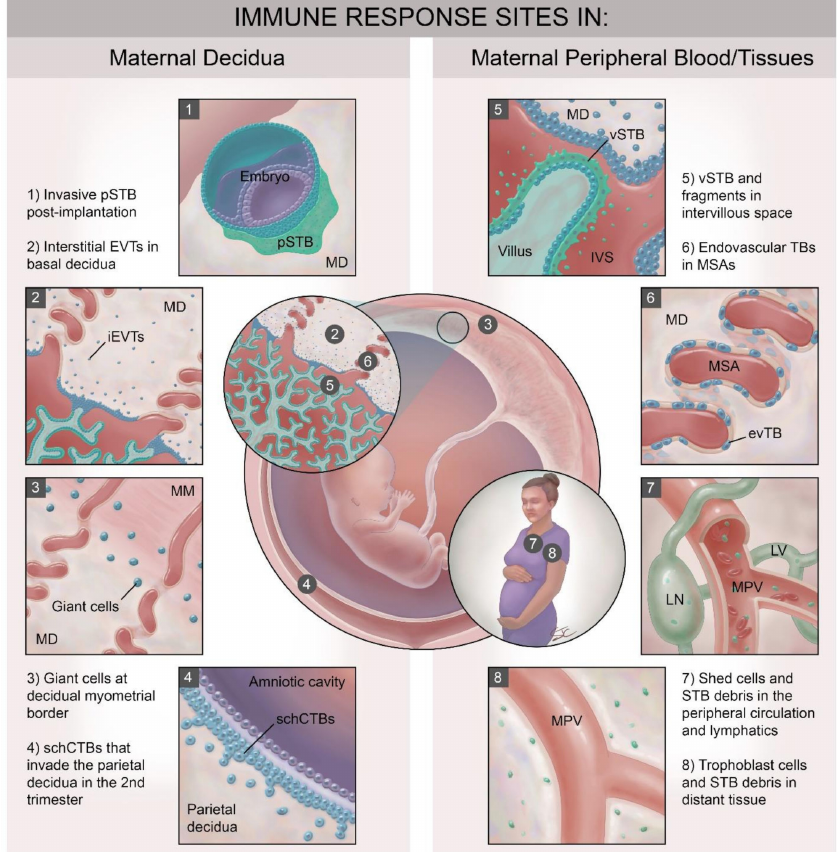
Figure 1. Sites of interaction between fetal-derived trophoblast and maternal immune cells in the pregnant woman. Trophoblast-derived material, entire cells and the multinucleated syncytiotrophoblast layer encounter maternal immune cells at no less than eight main sites. These can be divided into those that interact with systemic maternal immune cells in peripheral blood and peripheral tissues and those that encounter the specialized immune cell populations in the maternal decidua. EVT: extravillous trophoblast; evTB: endovascular trophoblast cells; iEVT: interstitial EVT; IVS: intervillous space; LN: lymph node; LV: lymphatic vessel; MD: maternal decidua; MM: maternal myometrium; MPV: maternal peripheral vessel; MSA: maternal spiral artery: pSTB: primitive syncytiotrophoblast, schCTBs: smooth chorionic cytotrophoblast cells; vSTB: villous